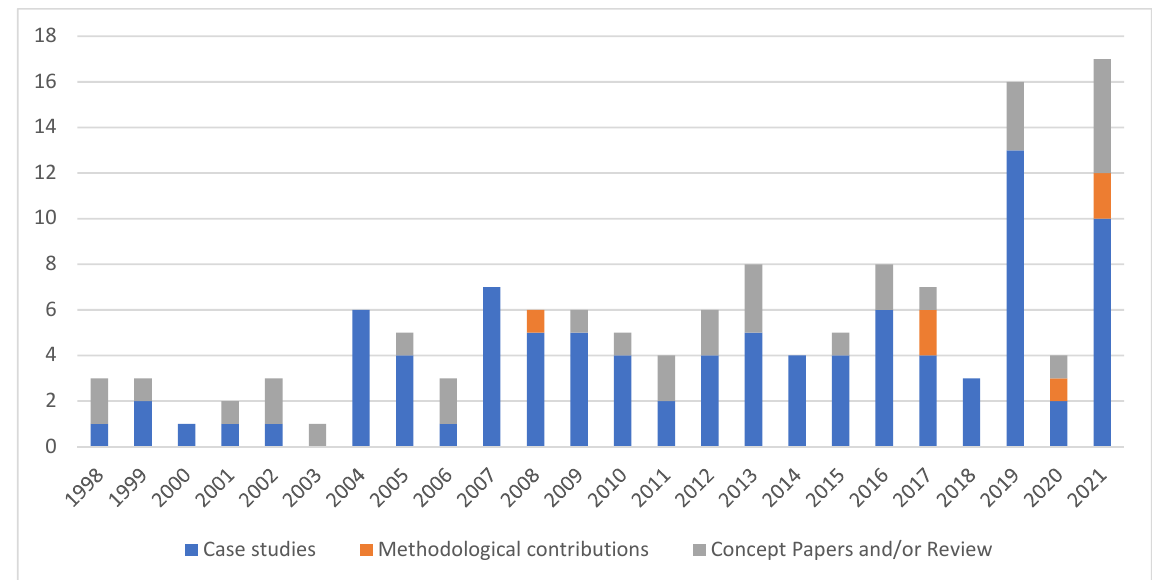
Figure 4. Types of research by year of publication.